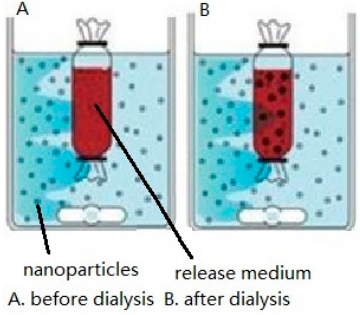
Figure 2. Reverse dialysis method ( A , B ).